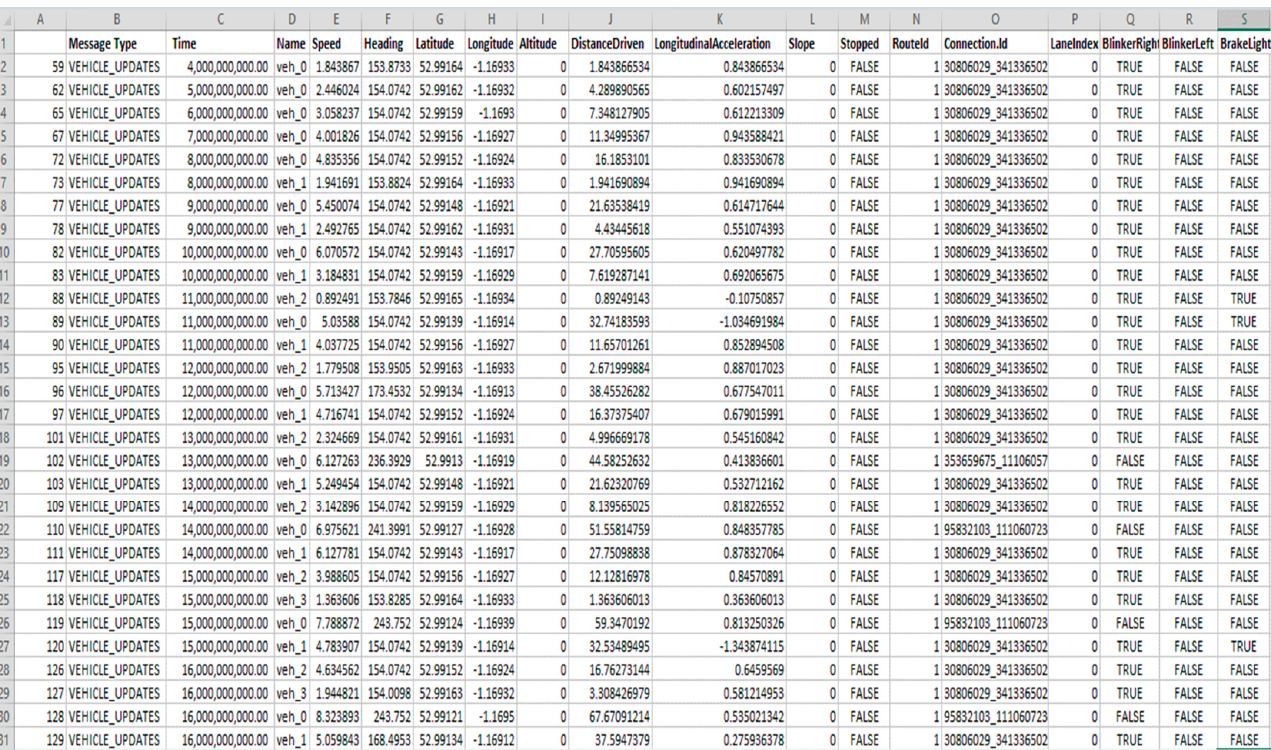
Figure 12. Message transformation.